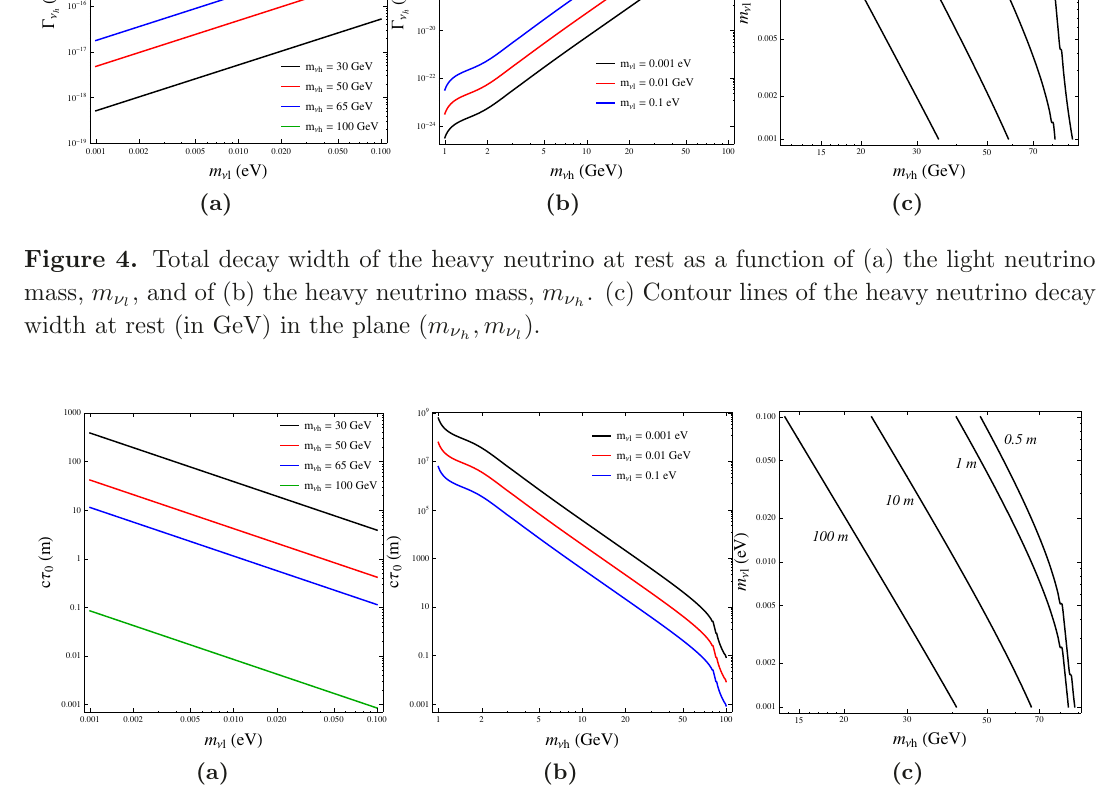
Figure 5. Proper decay length of the heavy neutrino as a function of (a) the light neutrino mass, m ν , and of (b) the heavy neutrino mass, m ν . (c) Contour lines of the heavy neutrino proper decay l h length in the plane ( m ν , m ν h l